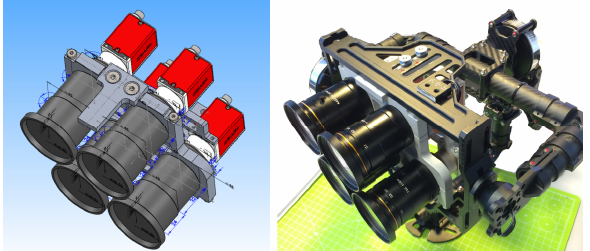
Figure 5. A four-camera system is under development. The system consists of one panchromatic camera for the reference aerial imaging and three spectral channels in the VIS/NIR range using appropriate bandwidth